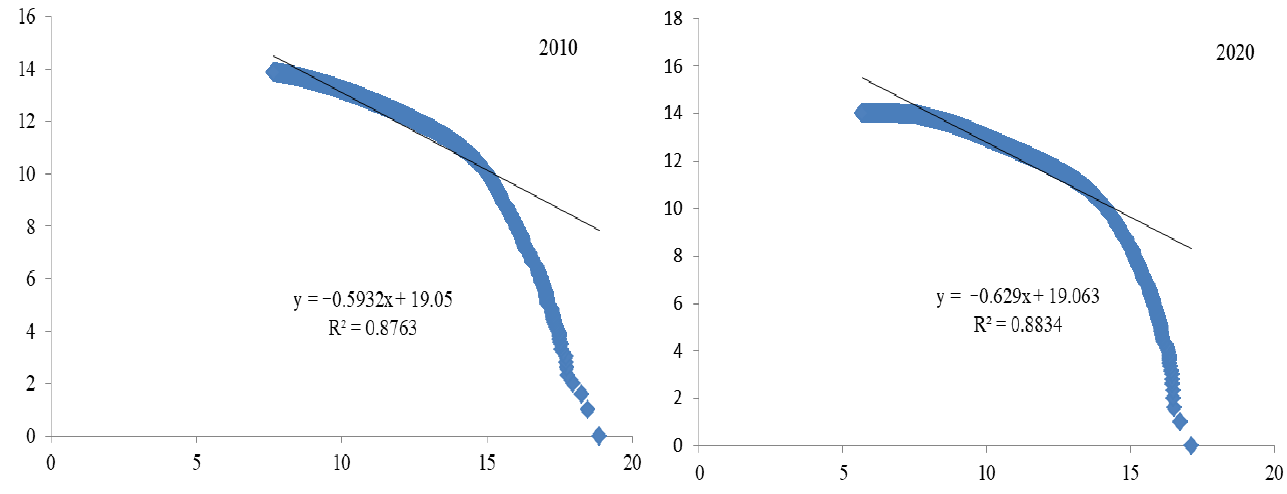
Figure 3. Rank − scale curve of rural settlements from 2010 to